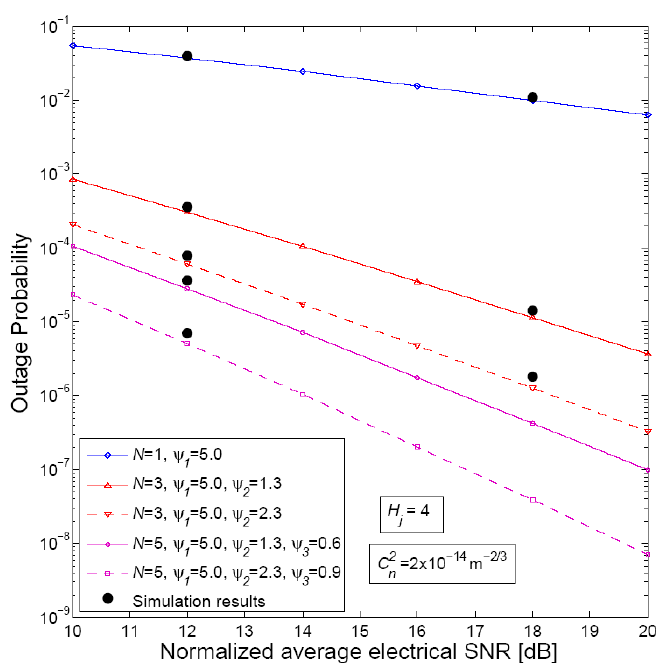
Figure 5 . Total outage probability (OP) of a quadruple-hop relay-aided system with varying path configurations as a function of a wide range of γ / μ , for gamma-gamma (G-G) modeled weak turbulent channels along with different amounts of pointing mismatch.